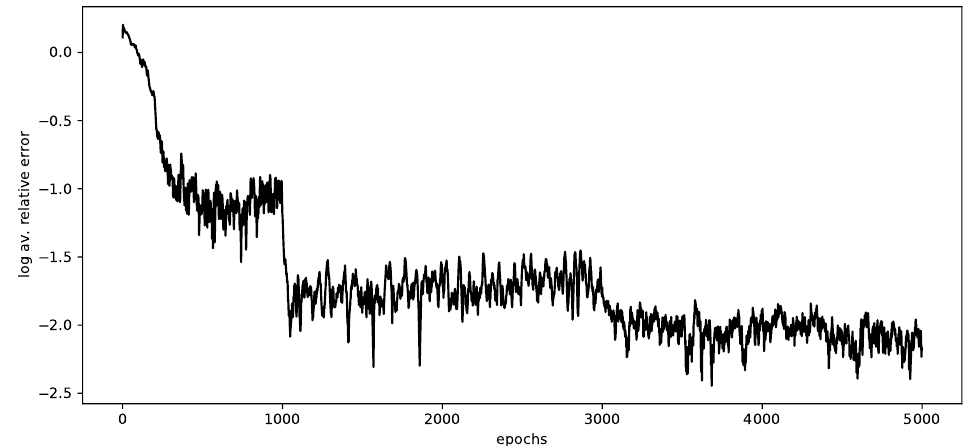
Figure 2. Log 10 -average relative error of U 0 ( 0,110 ) relative to the reference value 6.2825, based on 10 independent